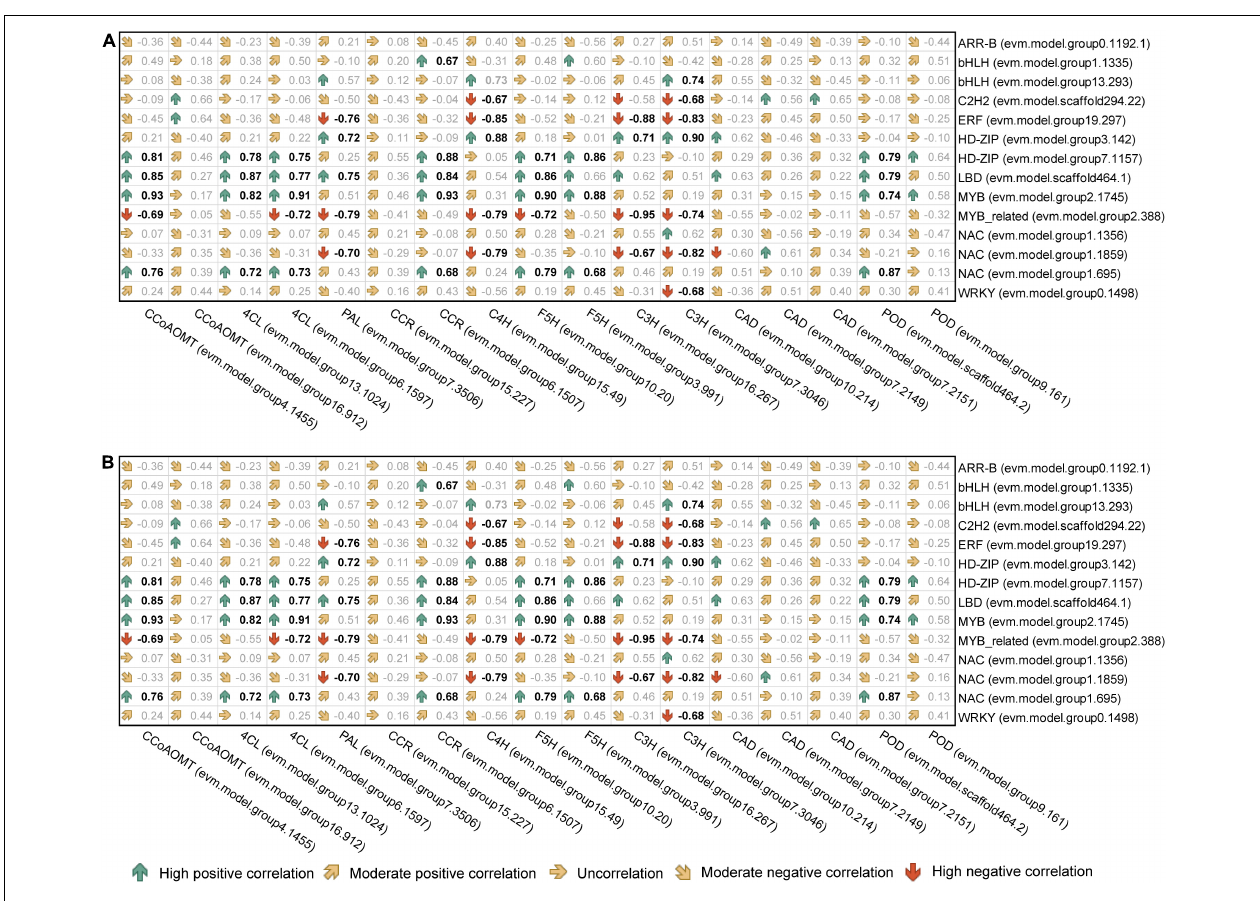
FIGURE 9 | Correlation analysis of the expression levels between candidate transcription factors and genes involved in lignin monomer biosynthesis. (A) The correlation coefficient between the transcription level of transcription factors and functional genes. (B) The correlation coefficient between the transcription level of transcription factors and the translation level of functional genes. Bold black indicates a P < 0.05 significance